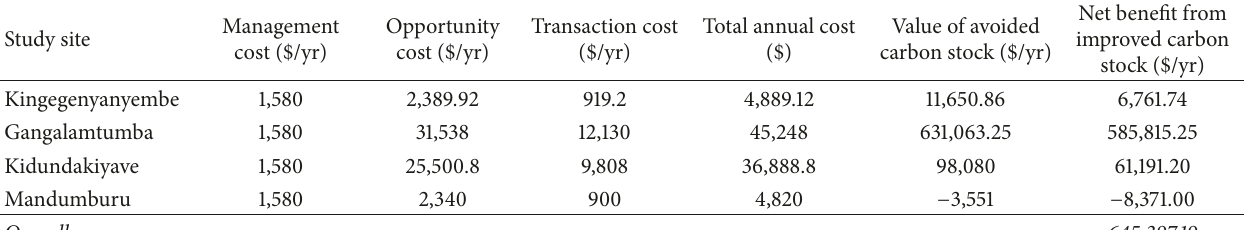
Table 7: Estimated costs and net benefit of improved carbon stock in voluntary market.